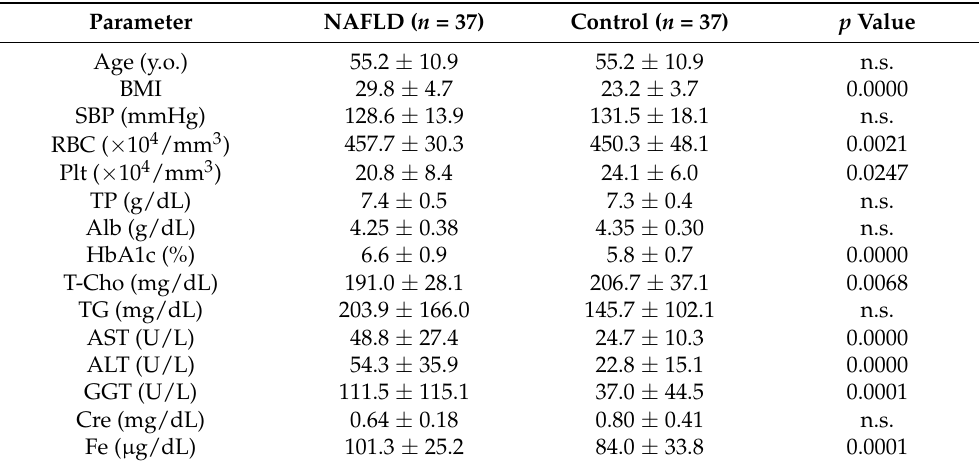
Table 1. Comparison of clinical data (NAFLD group, control group).